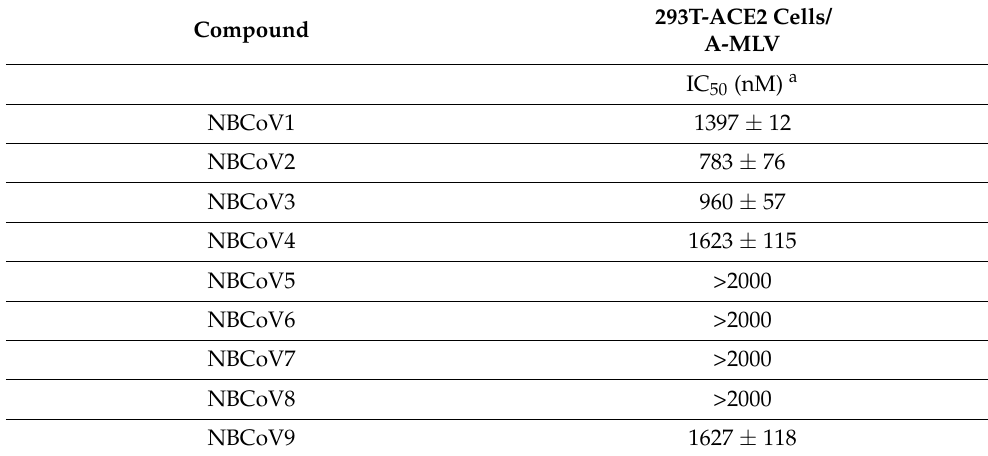
Table 4. Antiviral activity of the NBCoV small molecules against control pseudovirus NL4-3.Luc.R-E- /A-MLV (IC 50 ) evaluated in 293T/ACE2 cells.